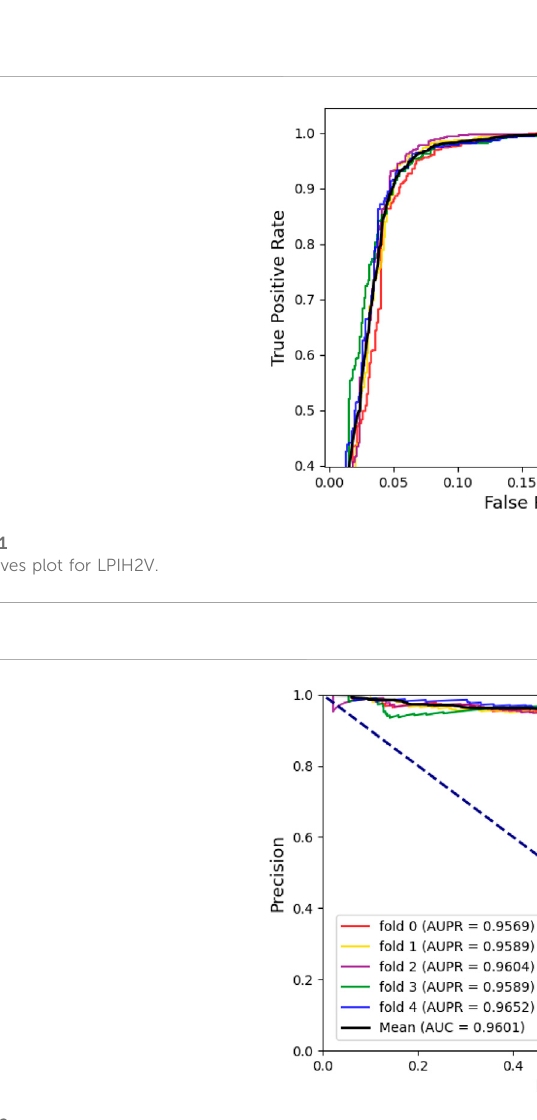
FIGURE 2 PRE curves plot for LPIH2V.